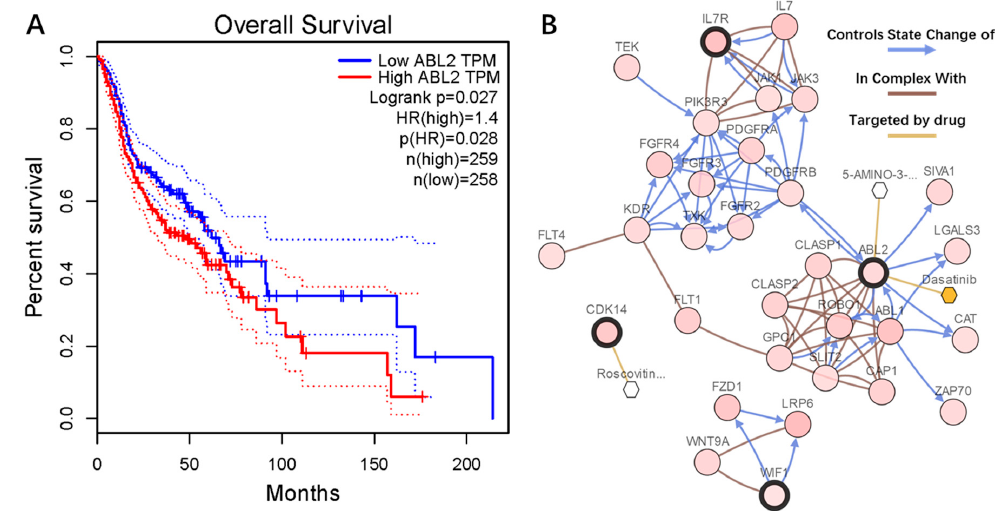
Figure 7. ( A ) ABL2 was significantly associated with overall survival in head and neck squamous cell carcinoma (HNSC) patients, using a Kaplan–Meier curve and a log-rank test. The patients were stratified into a high-level group and a low-level group according to median. ( B ) The network contained 54 nodes, including our four query genes and the 50 most frequently altered neighbor genes. The relationship between hub genes and drugs is also exhibited.